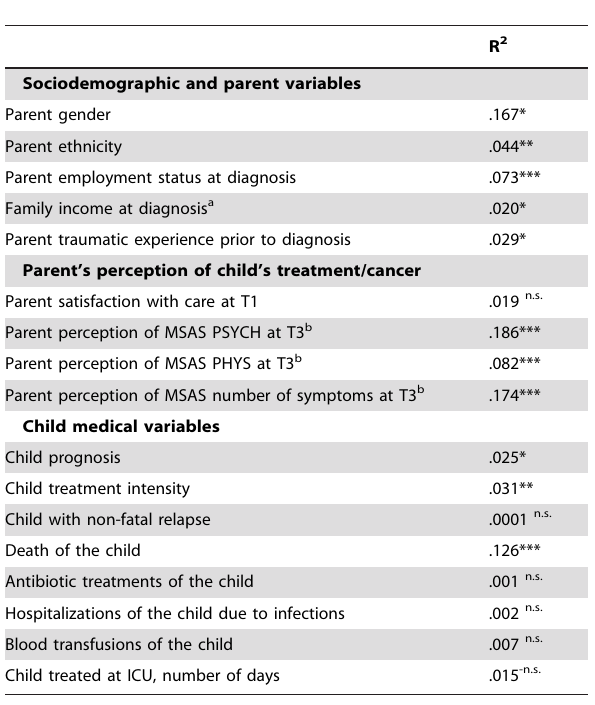
Table 3. Univariate associations between potential predictors and parental PTSS 12 months after completed treatment or death, or 18 months after transplant (Univariate linear regression; n= 224).